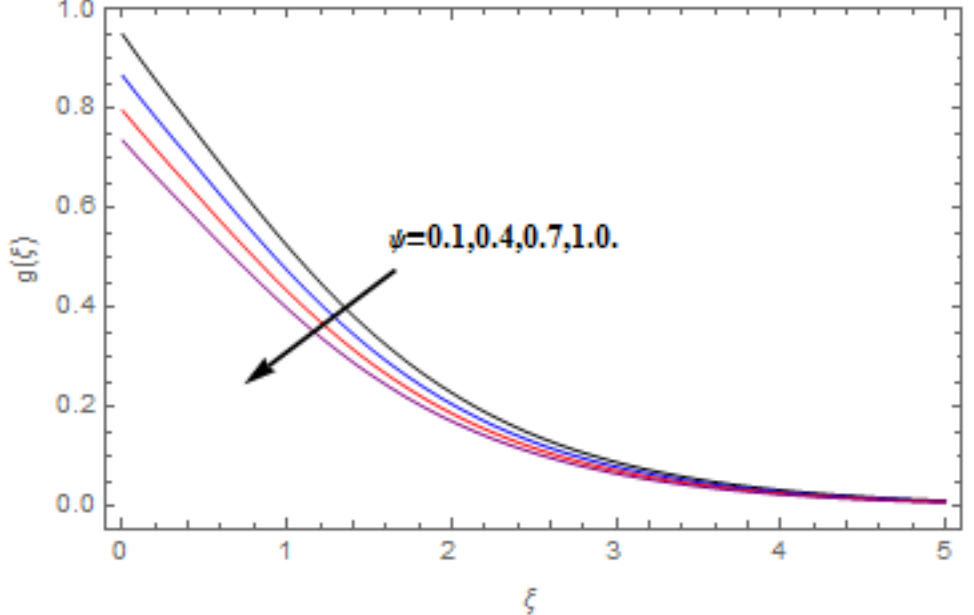
Figure 9. Varation in g ( ξ ) against ψ , when M = 0.2, Nt = Nb = 0.5, Le = 1.0, Ec = 1.0, Pr = 1.2, Figure 9. γ = 0.1, κ = 1.0. Molecules 2020 , 25 , x FOR PEER REVIEW